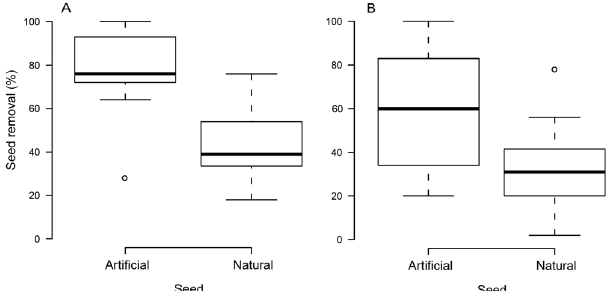
Fig 2 . Proportion of artificial and natural seed s removed by ants after 24 h of exposure in non-impacted (A) and impacted (B)